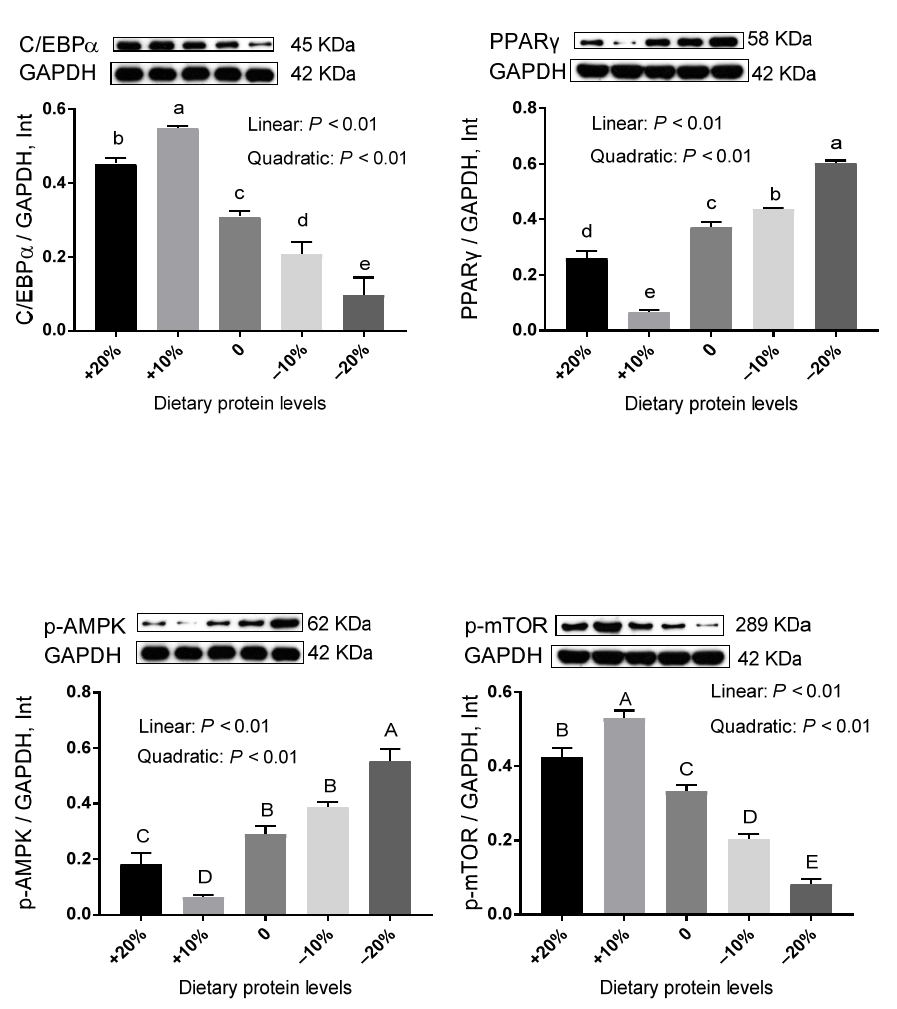
Figure 3. The relative protein expression level of genes related to lipid metabolism in the DSA of pigs fed different protein levels. Values are means, with their standard errors represented by vertical bars. a,b,c,d,e Values ( n = 3) within a row with different lowercase letters differ significantly ( p < 0.05) by the Kruskal–Wallis test. A,B,C,D,E Values ( n = 3) within a row with different capital superscripts differ significantly ( P < 0.05) by Duncan’s multiple comparisons. Table 3. The relative abundances of the top 10 microbial genera (%) in the colonic contents of pigs fed different protein levels.